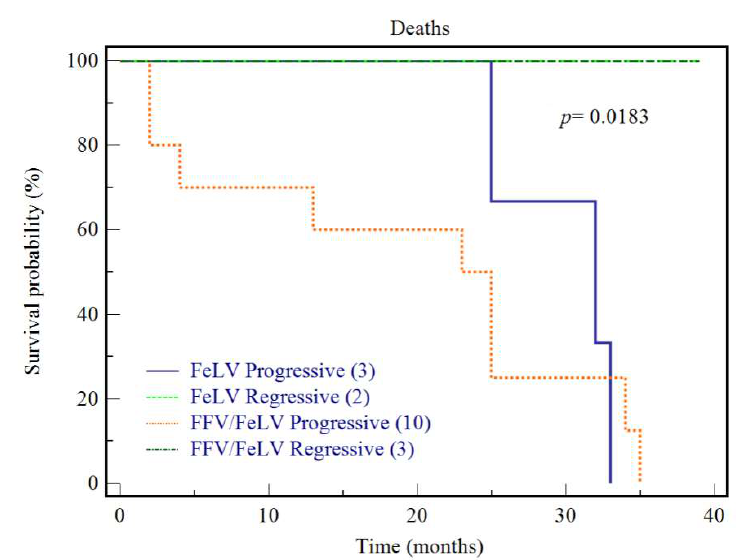
Figure 5. Survival analysis of cats with feline leukemia virus (FeLV) progressive and regressive infections irrespective of their FFV infection status. Kaplan-Meier survival analysis was conducted for cats that were followed-up over 35 months during the study. p -value of the comparison ( p ) is shown. Cats with regressive infections were more likely to survive during this period compared to cats with progressive infection ( p = 0.008).